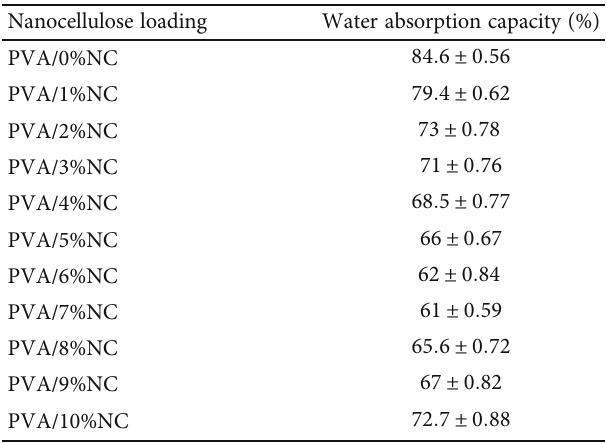
Table 2: Result of water absorption capacity of PVA composites with di ff erent NC loadings.